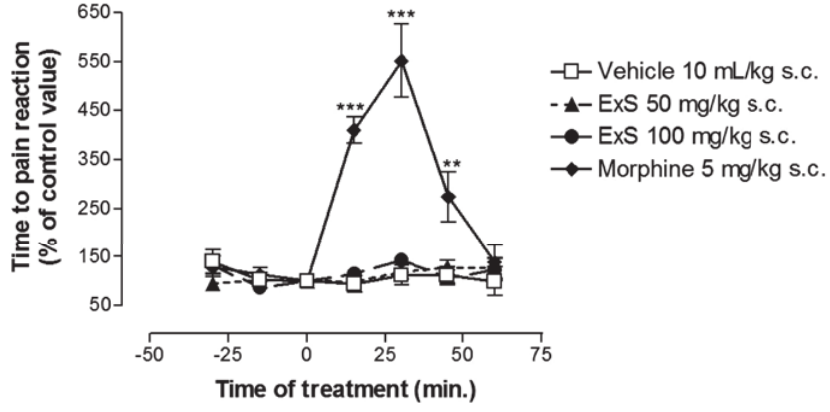
Figure 2 - Effect of Streptoverticillium sp. extract (ExS 50 and 100 mg/kg, s.c.) on the time to pain reaction in mice. The vertical bars indicate the mean ± SEM, expressed in relative percentage to the control group. Morphine (5 mg/kg, s.c.) was used as a positive control. ** p < 0.01, *** p < 0.001, vs control group (vehicle).